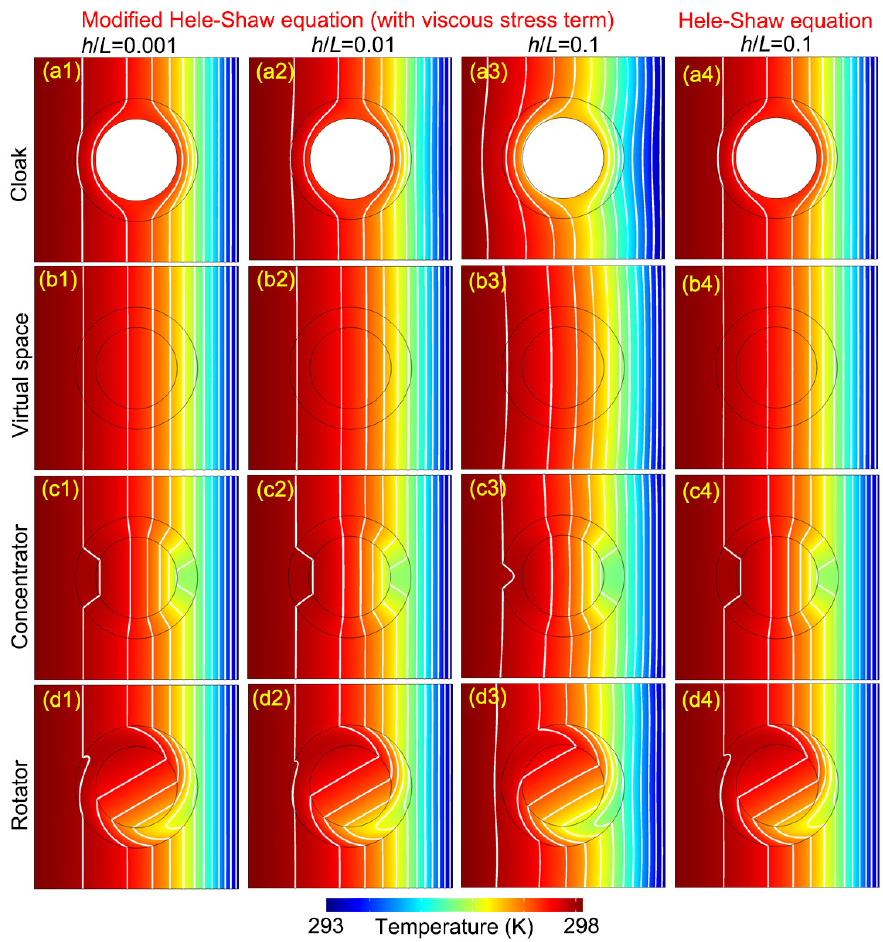
Figure 2. Simulation results of temperature distributions. The white lines are isotherms: ( a1 – a3 ) show the temperature distributions for the cloak when h / L is 0.001, 0.01 and 0.1, respectively. They use Equations (14) and (15) in governing equations; ( a4 ) shows the temperature distribution for the cloak at h / L = 0.1. It represents the result based on the strict Hele–Shaw flow model using Equations (10) and (12); ( b1 – b4 , c1 – c4 , d1 – d4 ) are the corresponding temperature distributions of the virtual space, the concentrator and the rotator,